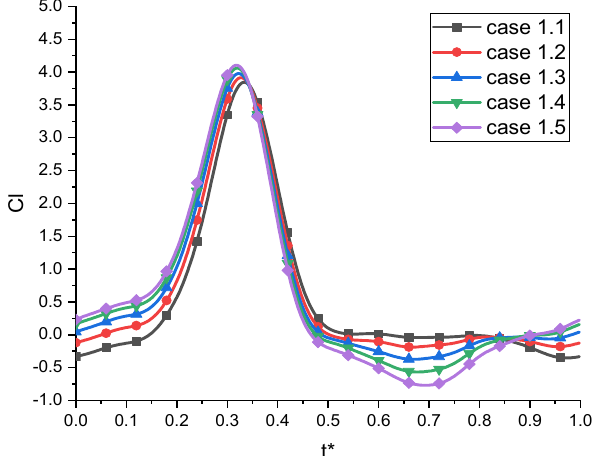
Figure 7. Instantaneous lift for cases in Table 3 with an AOA = 6°.